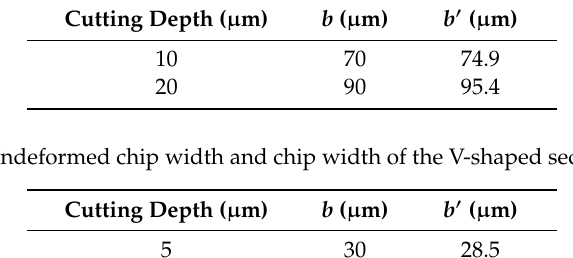
Table 1. Undeformed chip width and chip width of the trapezoidal section shape.